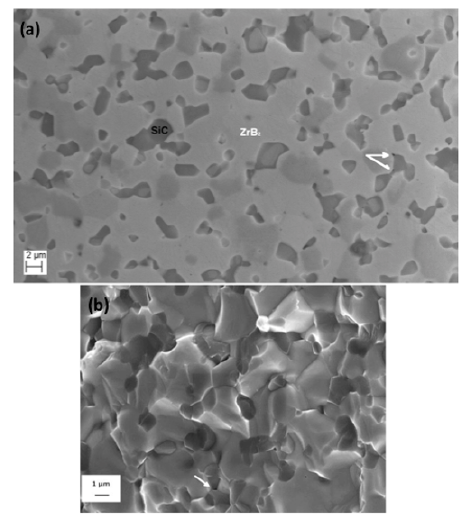
Fig. 6 Scanning electron micrographs depicted from the center region of a compression specimen after ~8% strain showing continuous microstructure with the formation of few cavities (white arrows) (a). Similar cavities were observed within the compressive region in flexure specimens (b). Samples corresponding to (a) and (b) were subjected to similar conditions of stress (~20 MPa) and temperature (1800 ℃